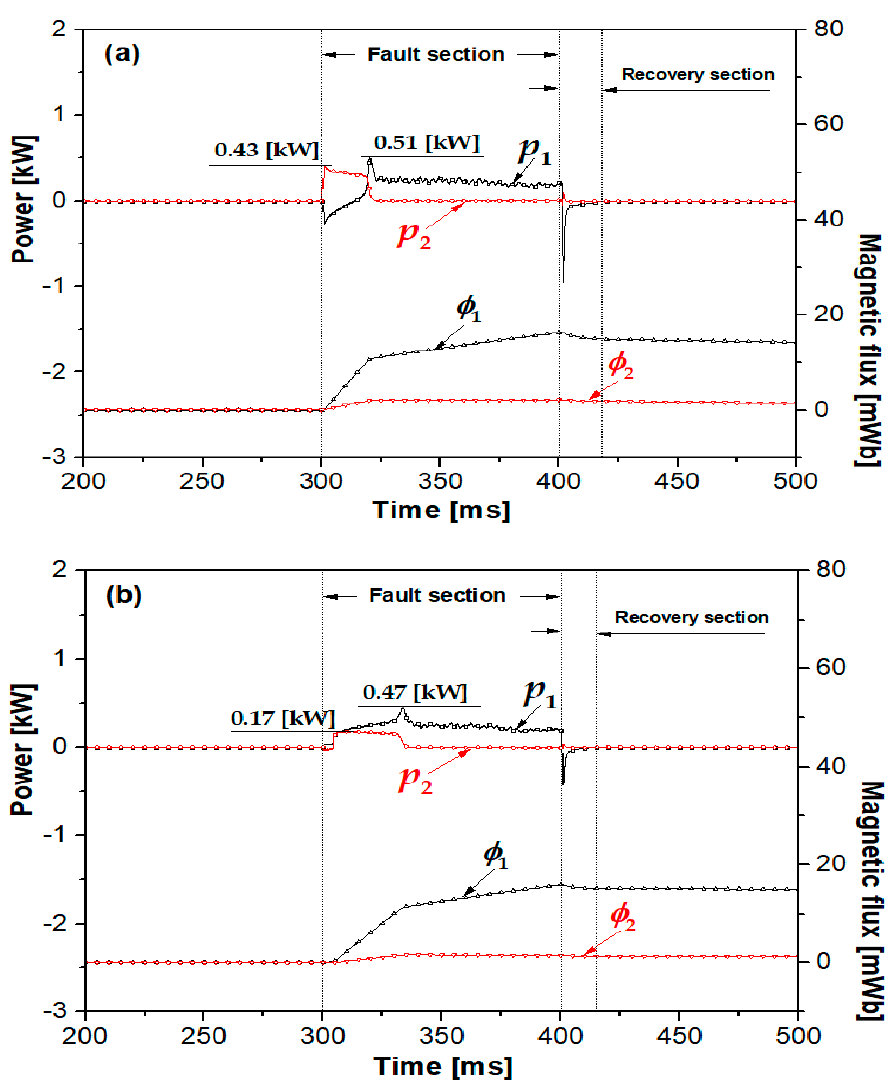
Figure 8. Instantaneous power burden and magnetic flux in each coil of the flux-coupled type SFCL in accordance the wiring direction: ( a ) for the additive wiring; ( b ) for the subtractive wiring.